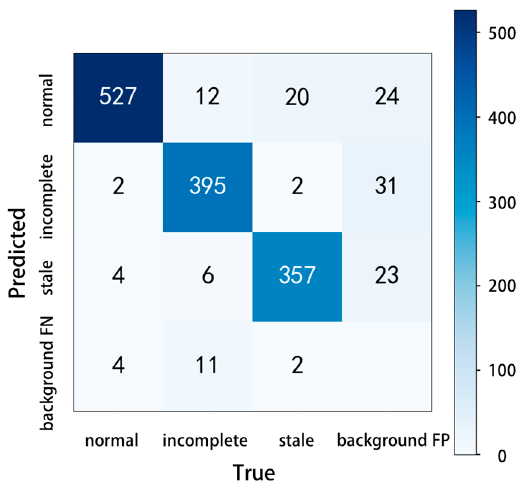
Figure 9. Confusion